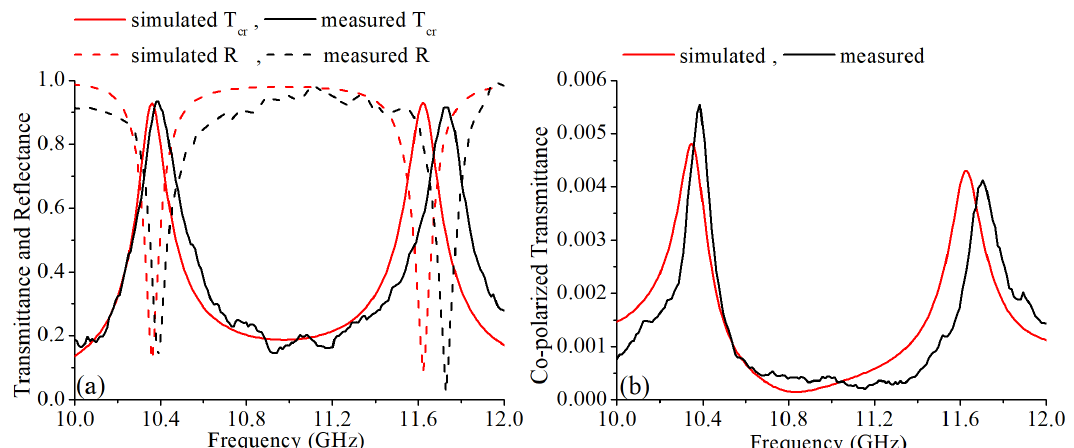
Figure 11. ( a ) The measured and simulated cross-polarized transmittances and reflectances. ( b ) The measured and simulated co-polarized transmittances.